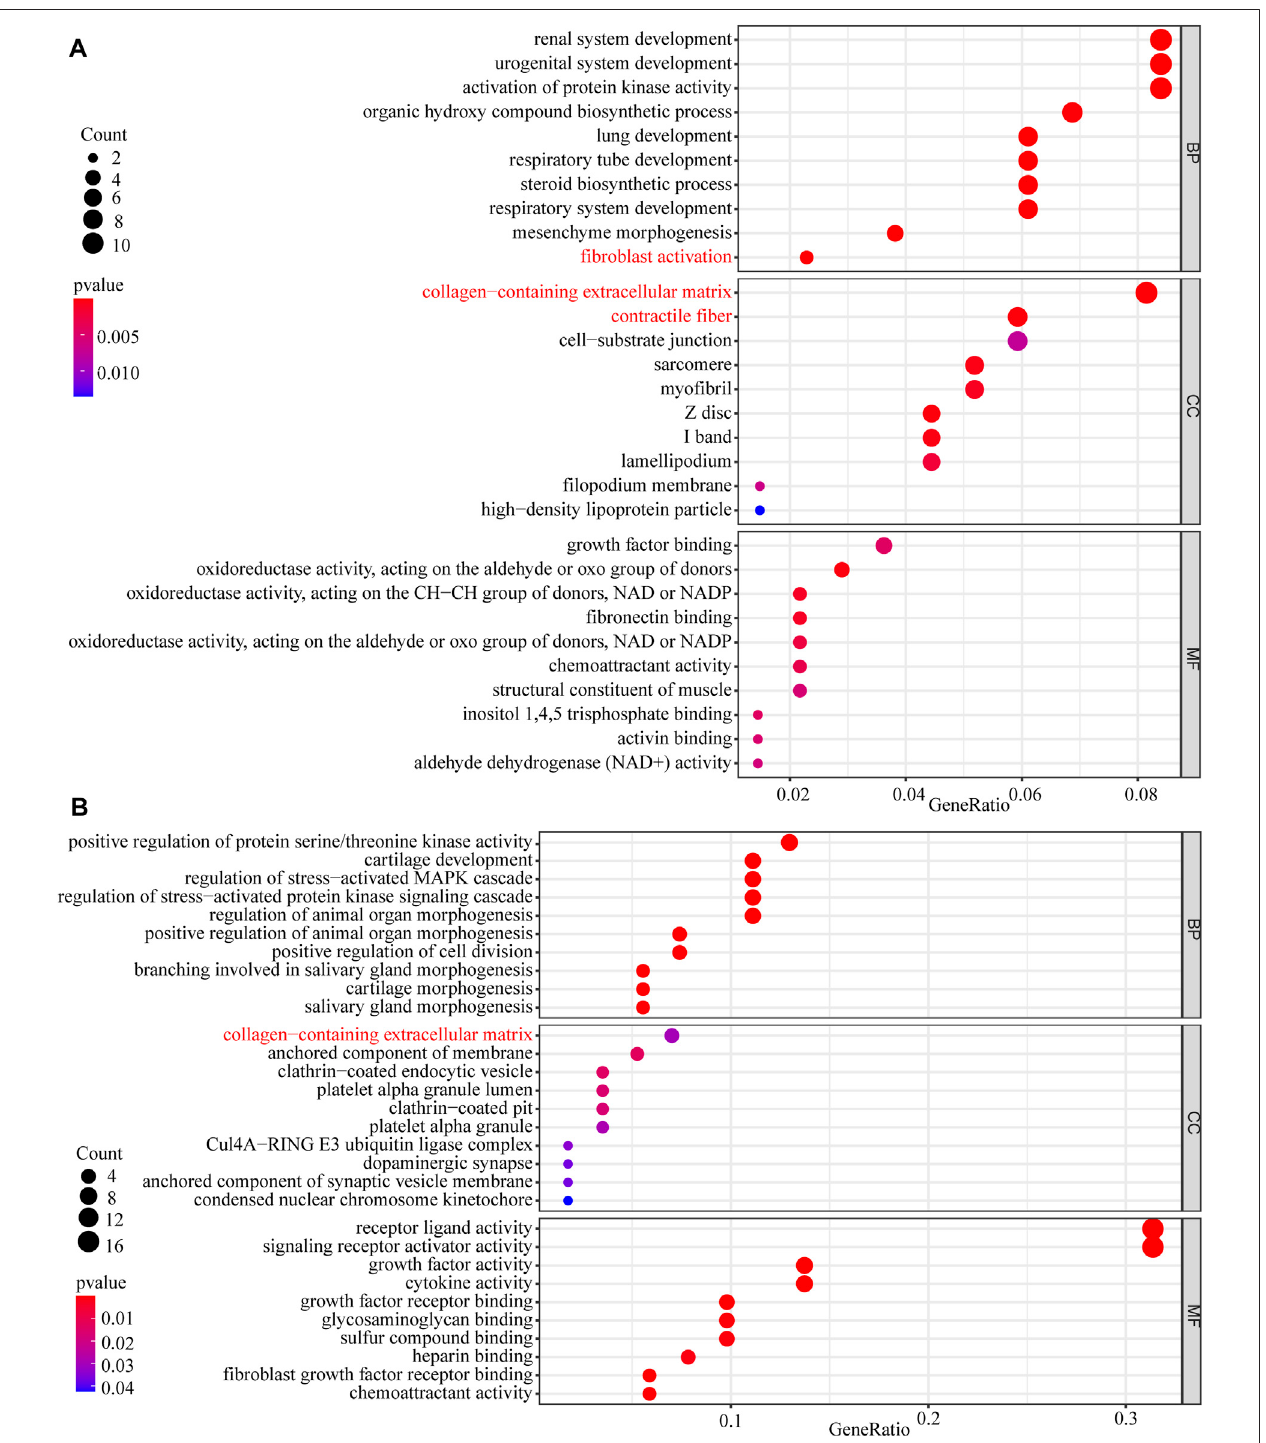
FIGURE 2 | The GO enrichment analysis of DEGs (A) The GO enrichment analysis of upregulated DEGs (B) The GO enrichment analysis of downregulated DEGs.